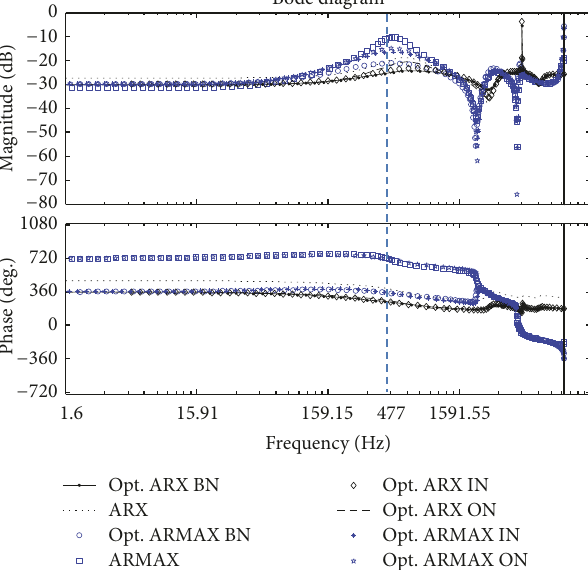
Figure3:BodeplotforARX(black)andARMAX(blue)realization; flow coefficient = 0.55.